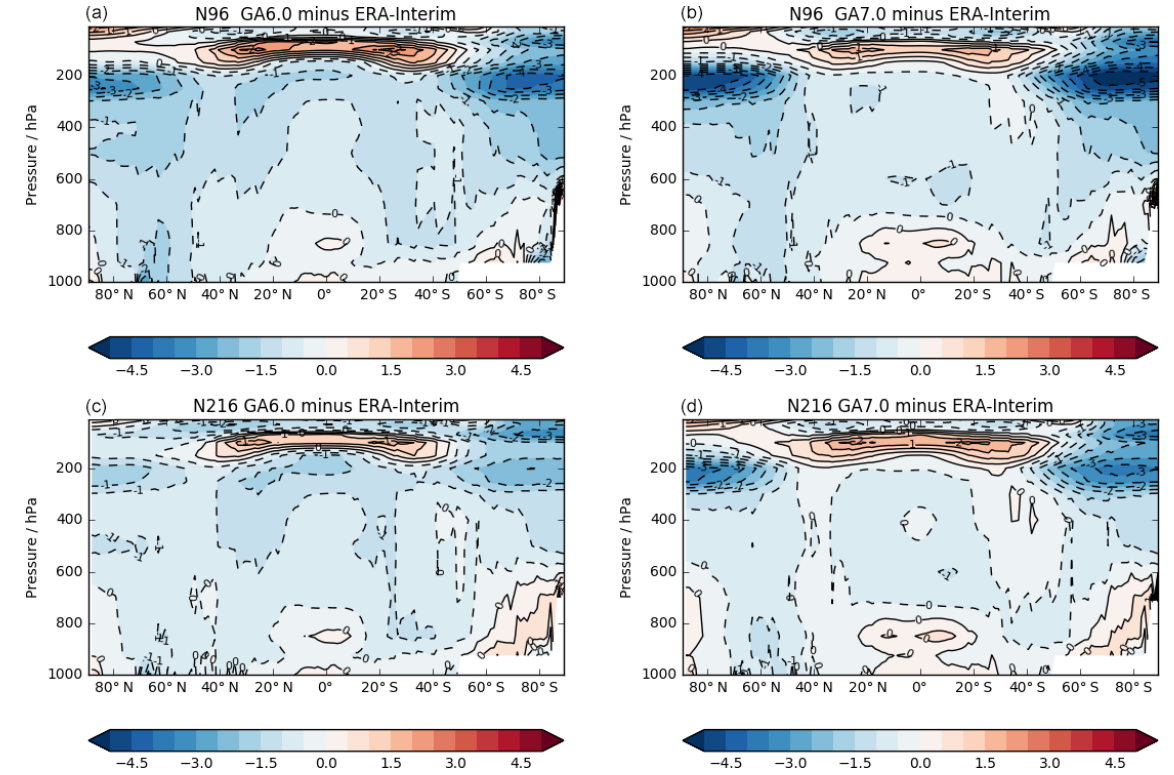
Figure 17. Annual mean zonal mean temperature biases (K) versus ERA-Interim in the 27-year N216 atmosphere/land-only climate simula- tions presented in Fig. 12 alongside results from equivalent simulations performed at N96 resolution. The rows show data from N96 (a, b) and N216 (c, d) , whilst the columns are data from GA6.0 (a, c) and GA7.0 (b, d) .